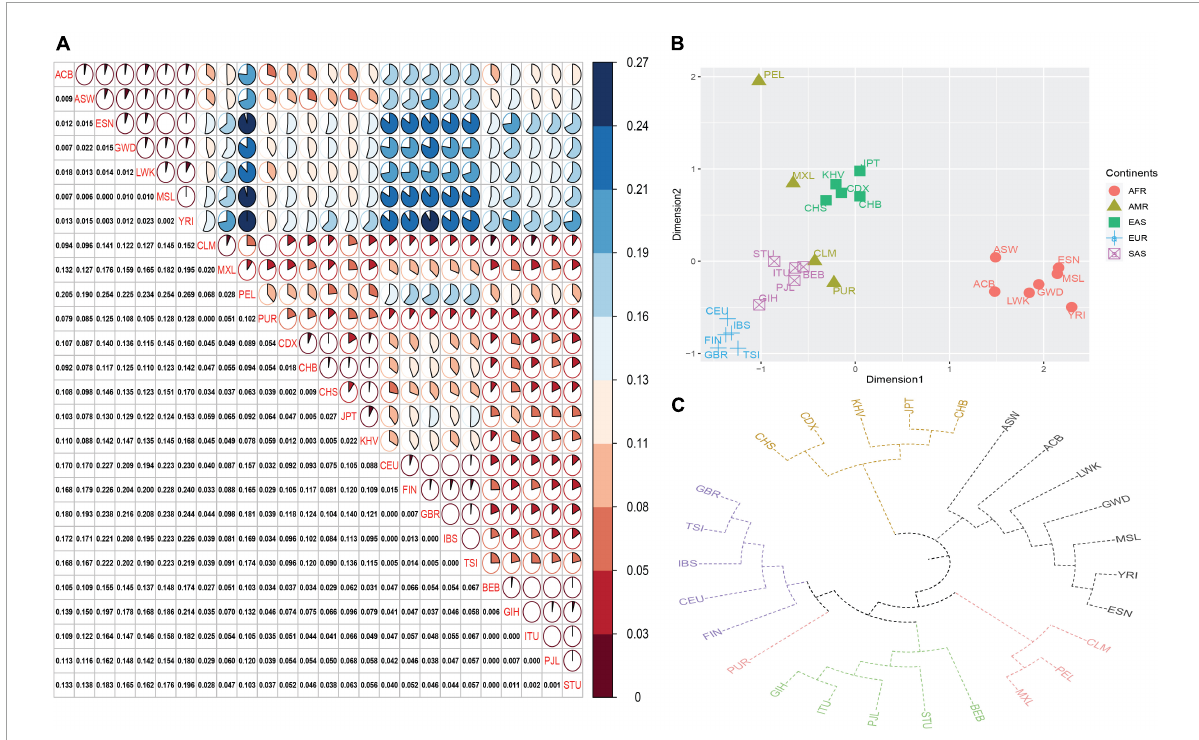
FIGURE3 Population genetic analyses of different continental populations based on selected 17 loci. (A) Pairwise F ST distances of different continental populations. Different colors represented different F ST values: red denoted small F ST values; blue denoted large F ST values. (B) Multi-dimensional analysis of different continental populations. (C) The phylogenetic tree of different continental populations.